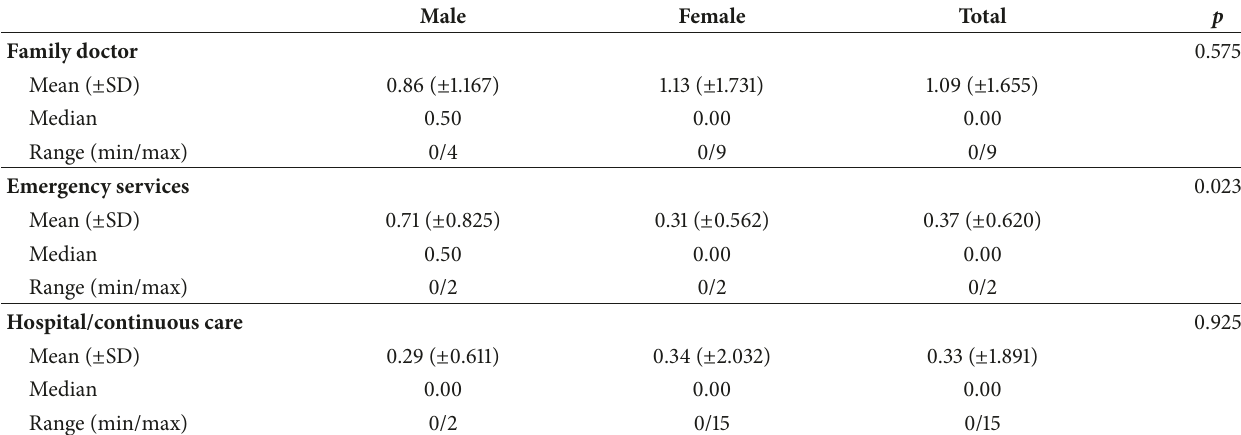
Table 5: Use of health services/support by the Portuguese centenarians from Beira Interior throughout the last year ( 𝑁 = 101).